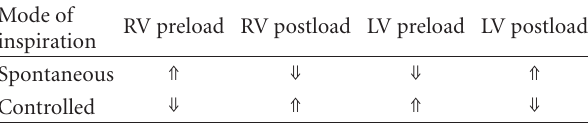
Table 1: Cardiorespiratory interactions used to predict volume responsiveness are listed. RV: right ventricle; LV: left ventricle.